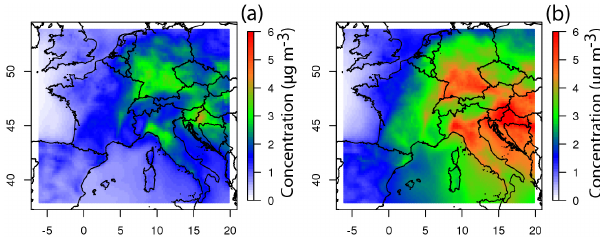
Figure 9. Modeled average BSOA concentration from isoprene and monoterpenes in the reference case (a) and from the KIN ap- proach (b) for the period 20 July–3 August